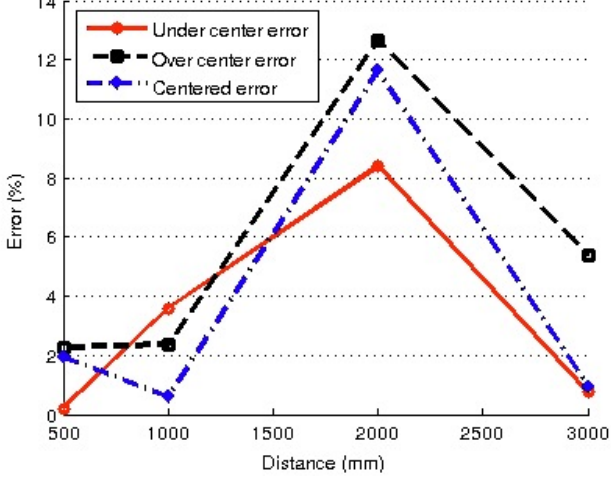
Figure 14. Errors in distance measurement when tested with adjusted